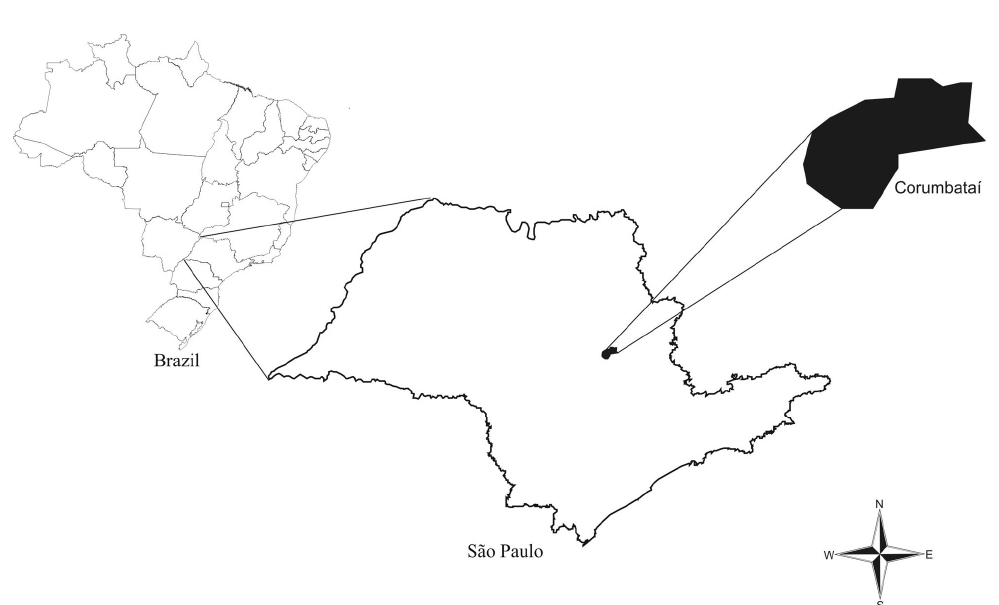
Fig. 1 – Localization of the municipal district of Corumbataí in the State of São Paulo,